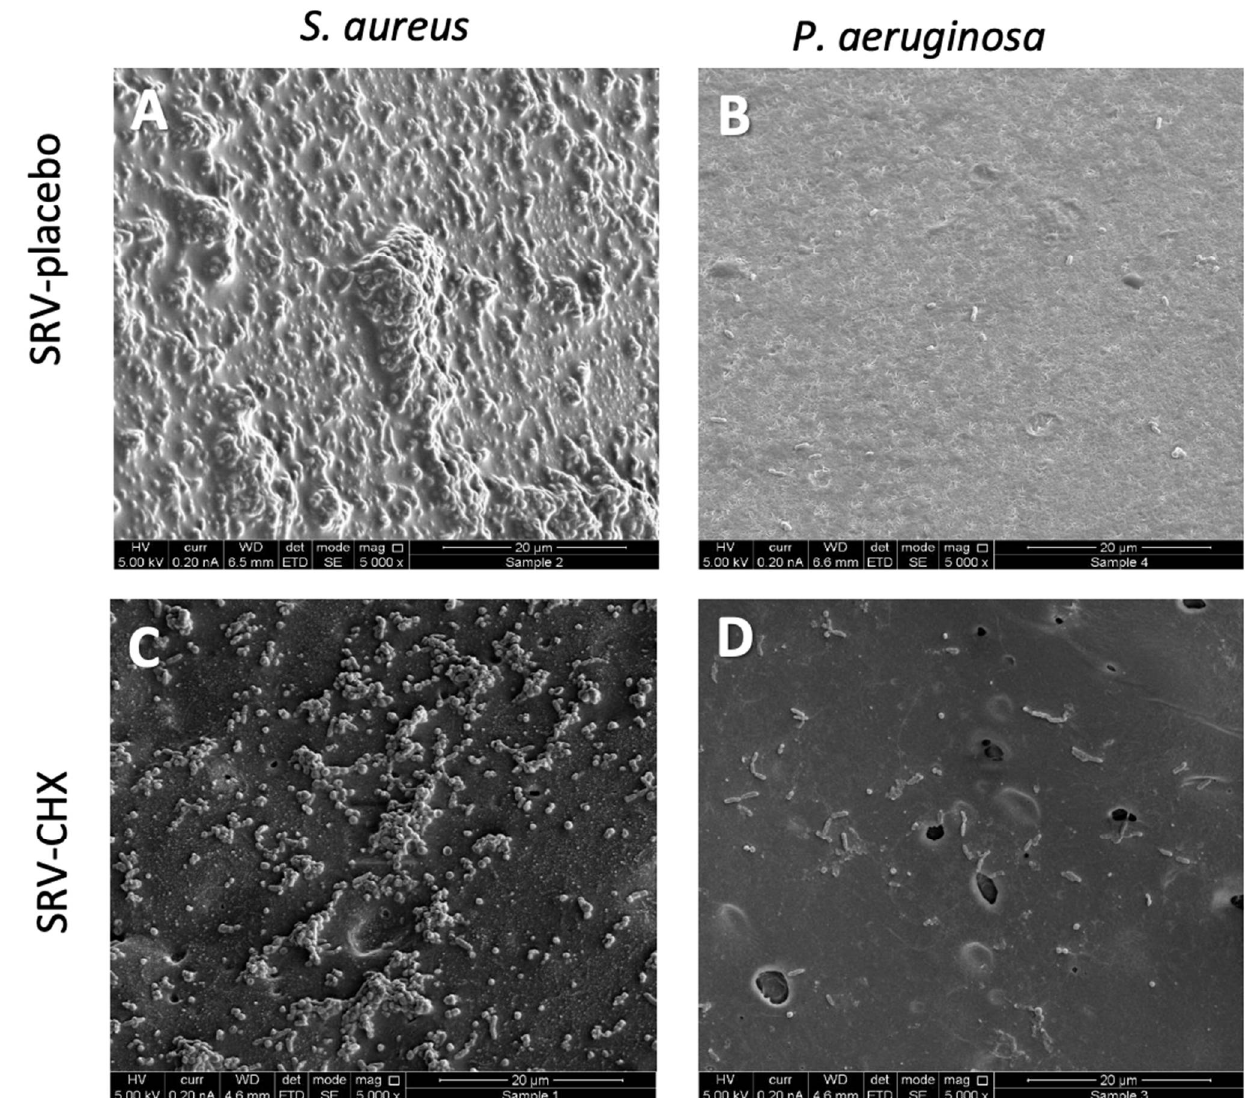
Figure 7. HR-SEM images of SRV-placebo- ( A , B ) and SRV-CHX-coated ( C , D ) SNS surfaces that have been exposed 7 times to planktonic growing S. aureus subsp. aureus ATCC 25923 ( A , C ) or P. aeruginosa ATCC HER-1018 ( B , D ). The ×5000 mag- nification is shown.